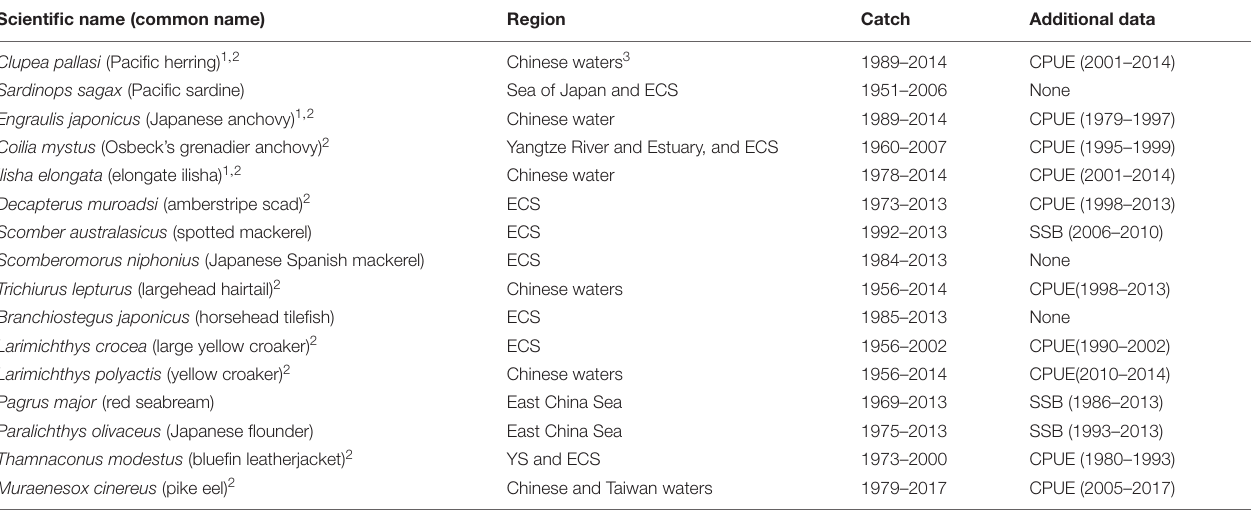
TABLE 1 | Summary of data available for the stock assessments presented here (the data themselves and data sources are presented in Supplementary Table 1